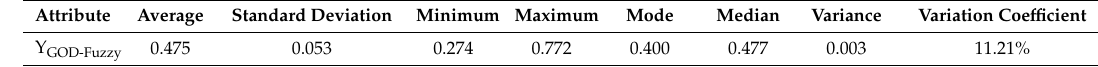
Table A8. Exploratory analysis of well